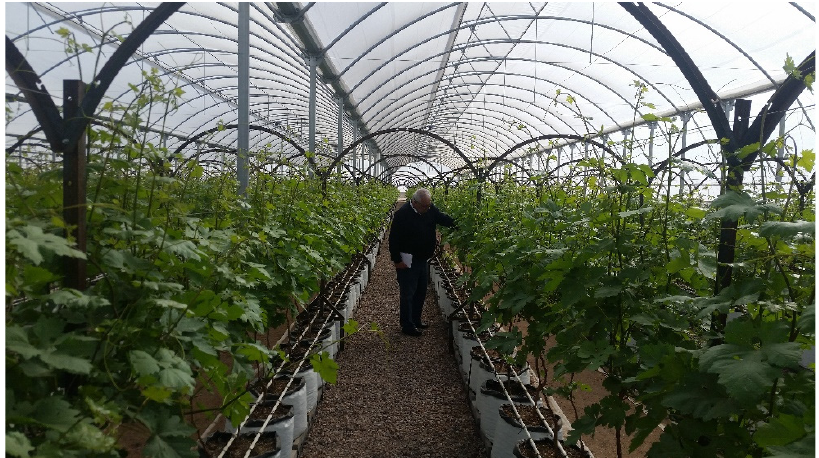
Figure 4. Table-grape soil-less cultivation in polyethylene containers under high-technology greenhouse in the Hermosillo area (Mexico).